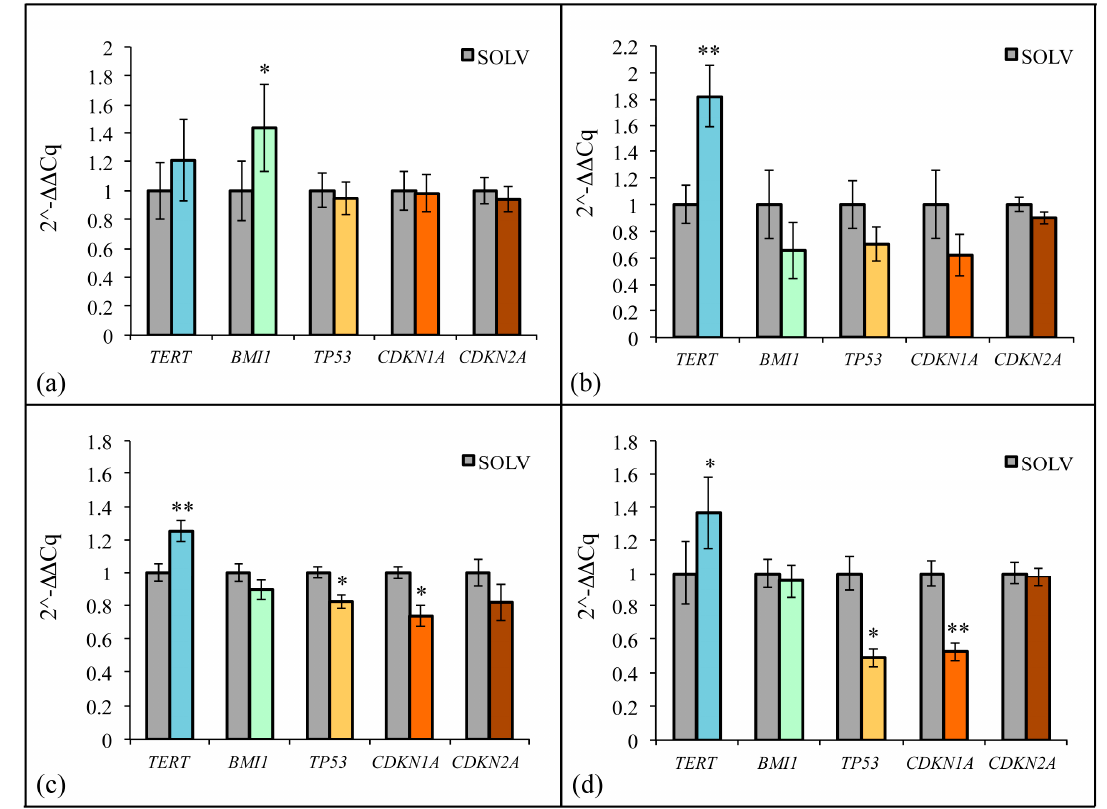
Figure 10. Effect of ZF1 on gene expression in hMSCs. The hASCs ( a ), hBM-MSCs ( b ), hDP-MSCs ( c )